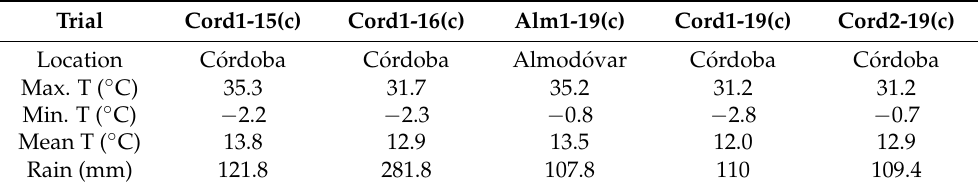
Table 2. Field trials carried out for the study of the effect of cultivar mixtures on the pathosystem pea/powdery